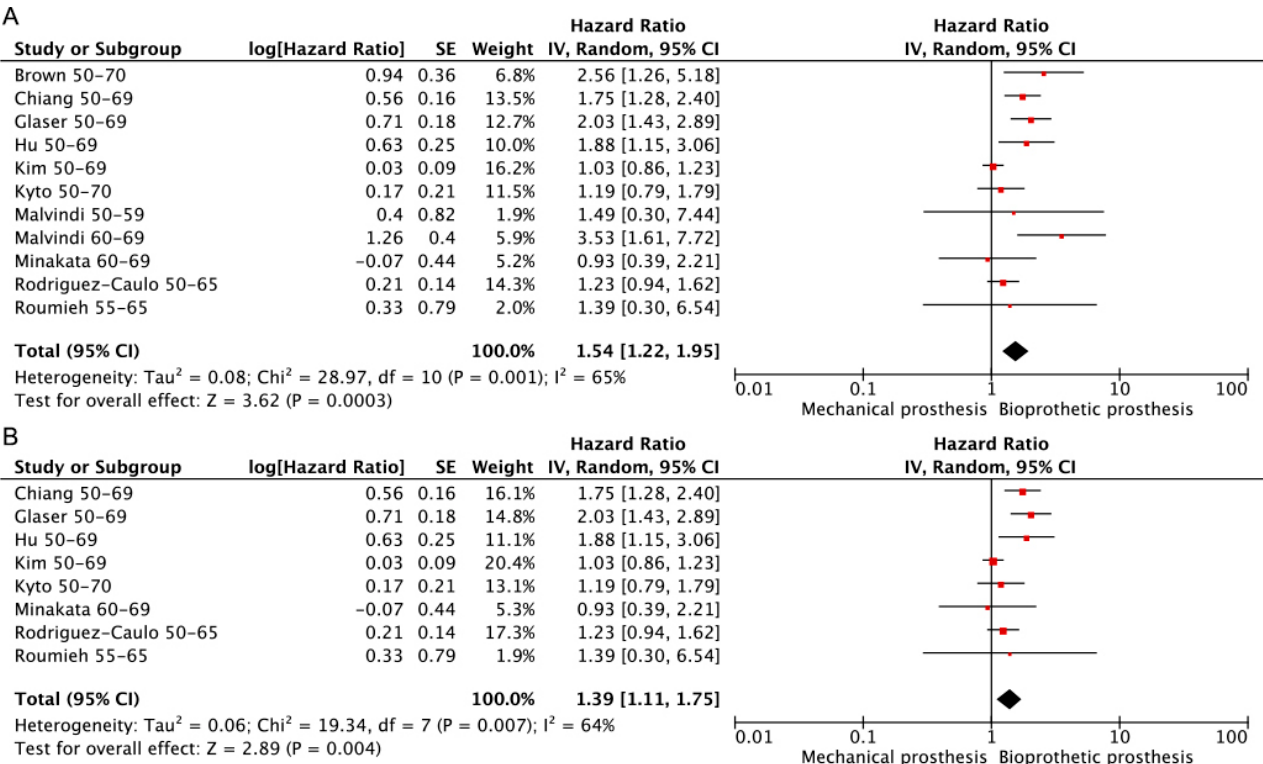
Figure 7. Meta-analysis for freedom from bleeding. ( A ) Bioprosthetic vs. mechanical. ( B ) Biopros- thetic vs. mechanical (RCT or PSM).